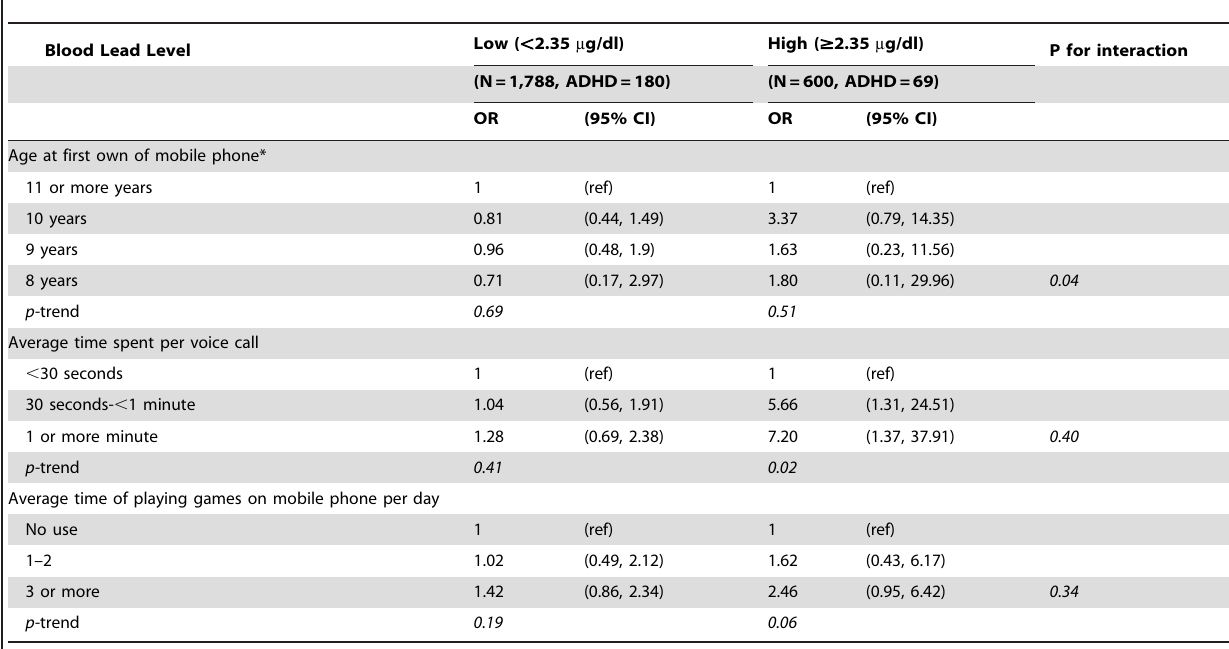
Table 4. Simultaneous Model of Mobile Phone Use Variables Associated with ADHD in Children Stratified by the Blood Lead Level, 2008–2010, Korea, the CHEER study.